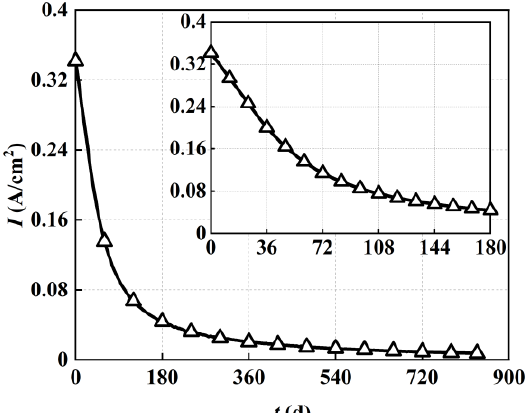
Figure 12. The variation in output current density of direct internal reforming solid oxide fuel cell during 20,000 h of steady − state operation.